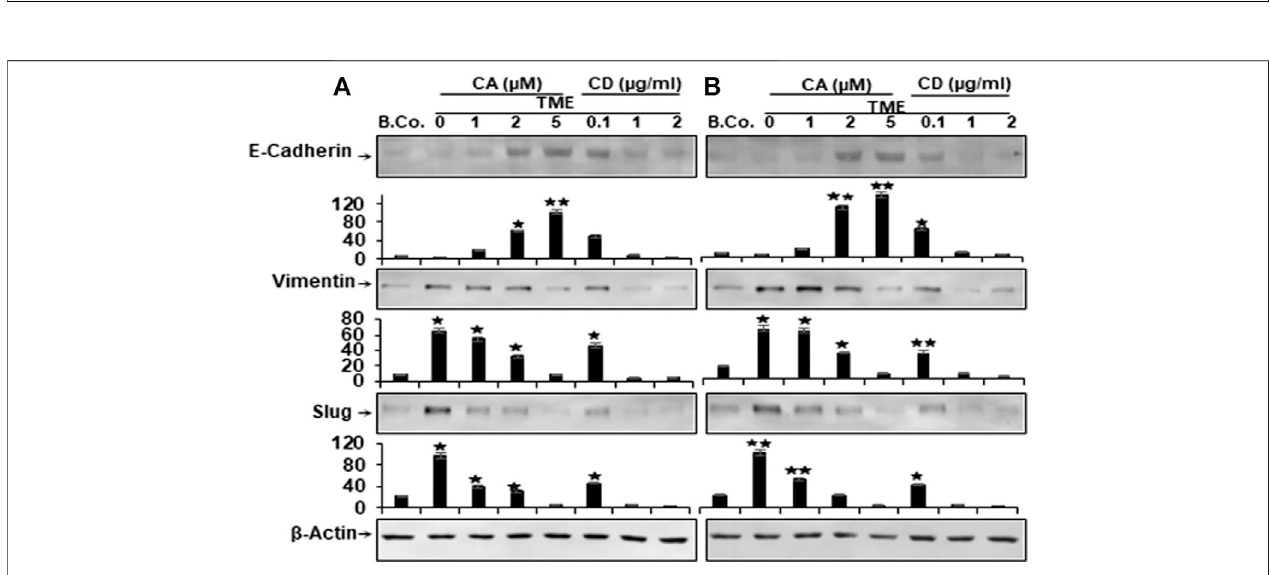
FIGURE6| CalebinAorcytochalasinDactionsonEMT-speci fi cbiomarkersincolorectalcancercells.HCT116 (A) andRKOcells (B) inalginatebeads(B.Co.)orin TME were maintained alone or treated as outlined to the previous. Immunoblotting of total samples was performed by Western blotting using antibodies to E-Cadherin, vimentin and Slug. Indicated are the results of at least three separate assays, with β -Actin serving as loading control. Densitometric analysis was performed for the indicated proteins. * p < 0.05, ** p < 0.01 relatively to basal control.